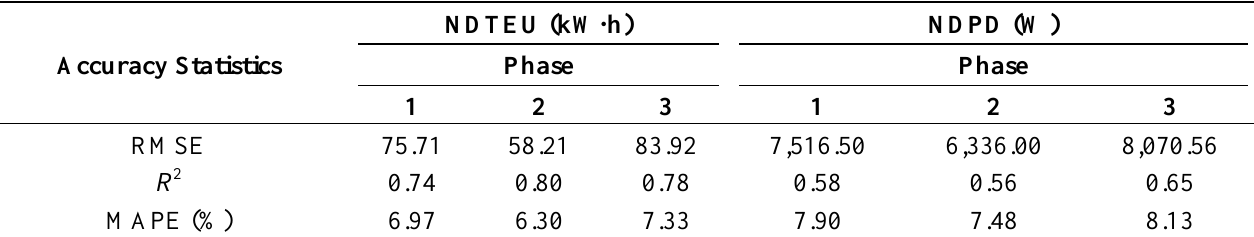
Table 3. ARIMAX validation statistics.